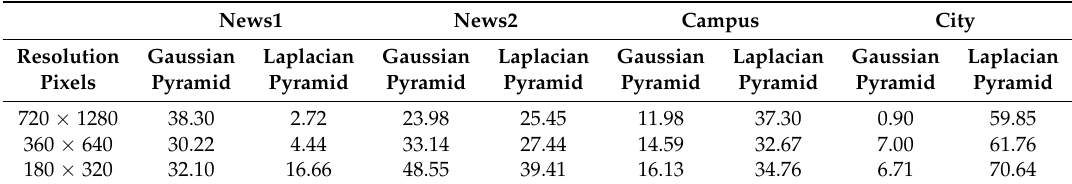
Table 5. Approximation Error : Per Cent Error = | P 2 − P 1 | ( X 1, B ) P 2 = 1 log MSE ; A = X 2 and B = X 3 for Gaussian Pyramid and A = X 3 and B = X 4 2 MSE ( X 1, A )